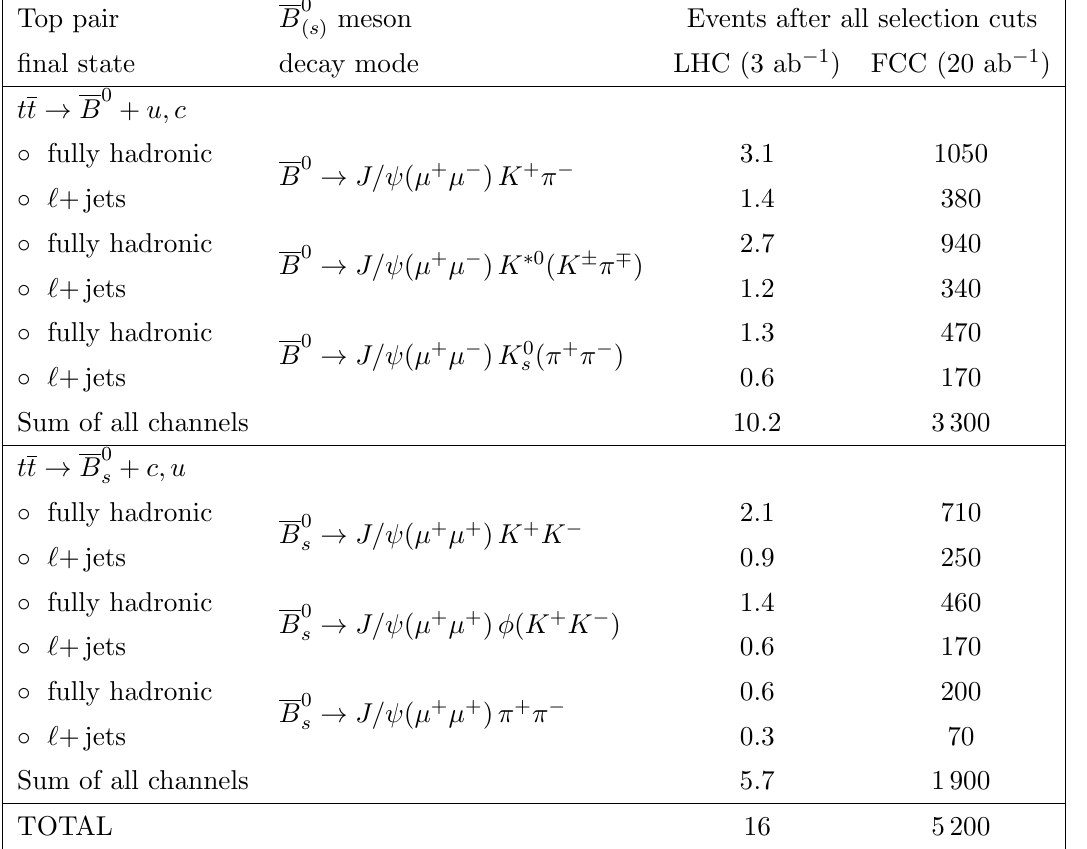
Table 7 . Expected number of t ! B 0 + jet events in selected tt (cid:12)nal-states (fully hadronic, and ( s ) ‘ + jets) with B 0 -mesons decaying into J= plus light hadrons, after estimating branching ratios and detector acceptance losses, for pp collisions at the LHC and